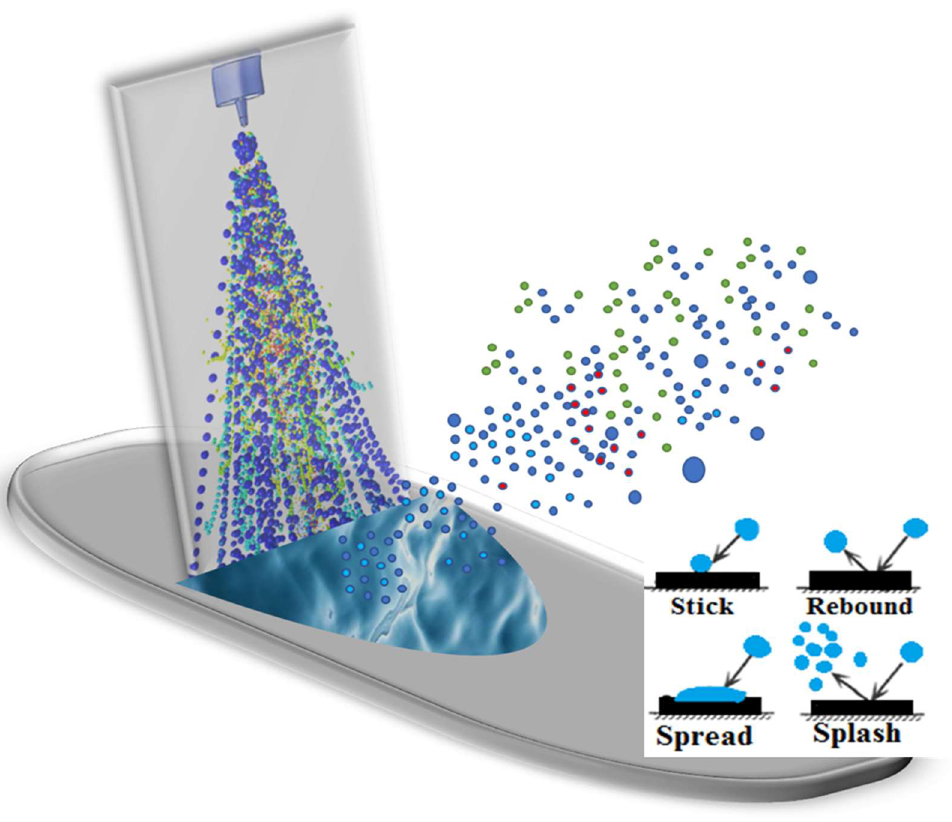
Figure 1. Graphical representation of liquid spray interaction with a wall surface at the point of impaction (colors are representative of a polydisperse spray droplet distribution).